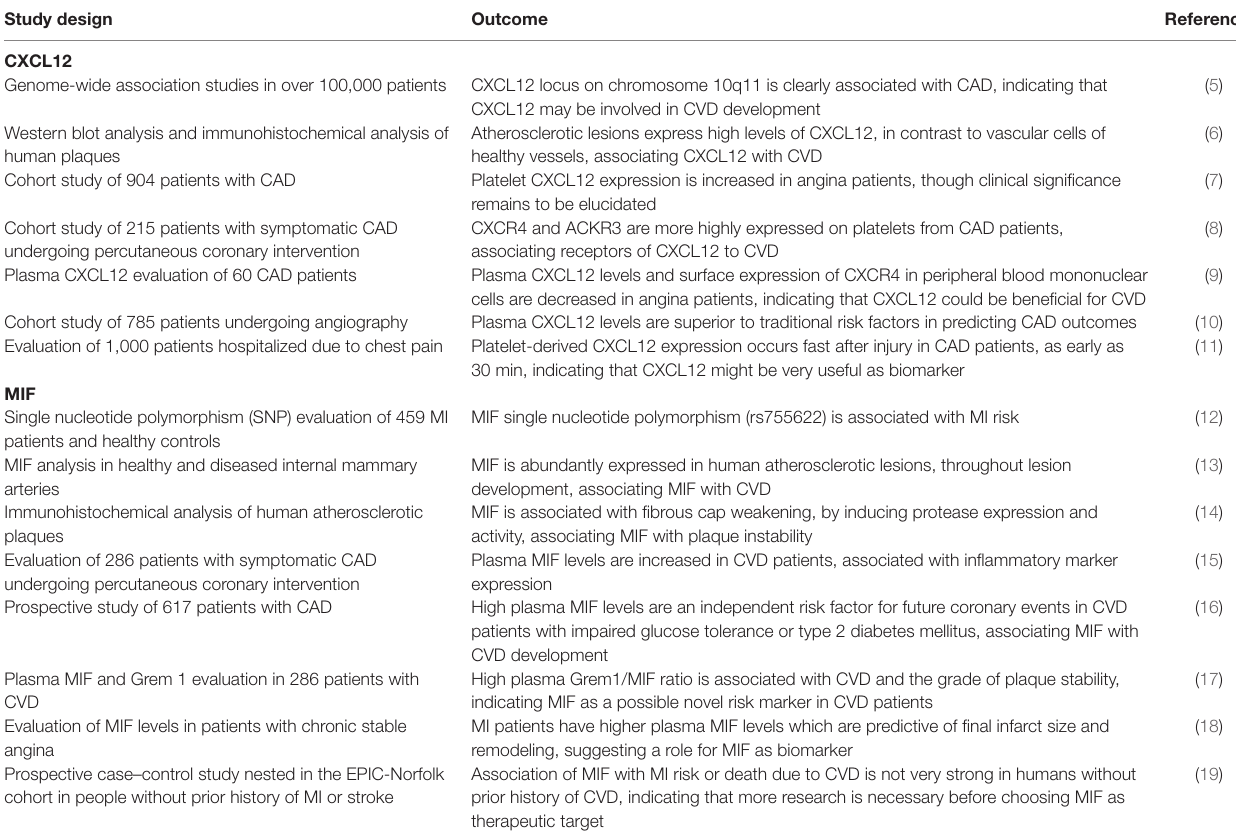
TABLe 1 | Overview of human studies on CXCL12 and MiF in